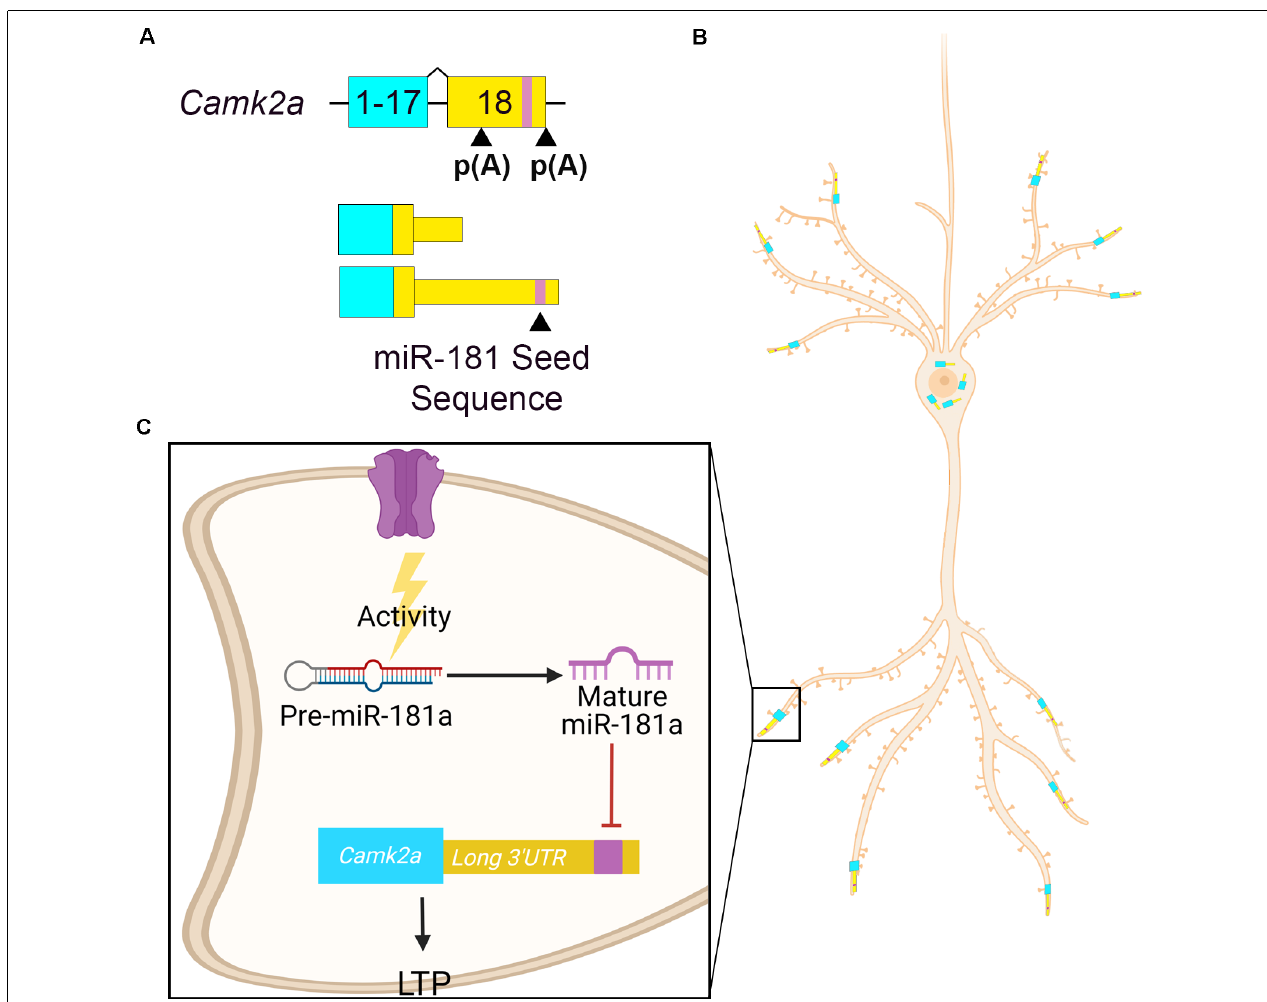
FIGURE 3 | Camk2a APA drives its localization and activity-dependent miRNA regulation. (A) Camk2a APA [p(A)] in exon 18 determines the 3 (cid:48) UTR length. The distal p(A) site results in a longer 3 (cid:48) UTR that contains a miR-181a binding site (purple). (B) Camk2a with the shorter 3 (cid:48) UTR localizes to the cell soma, whereas Camk2a with the longer 3 (cid:48) UTR localizes to neurites. (C) Pre-miR-181a is present at hippocampal synapses. In response to synaptic activity, it is processed by DICER into its mature active form. Mature miR-181a then represses the translation of Camk2a by binding to its seed sequence in the long 3 (cid:48) UTR. This results in the inhibition